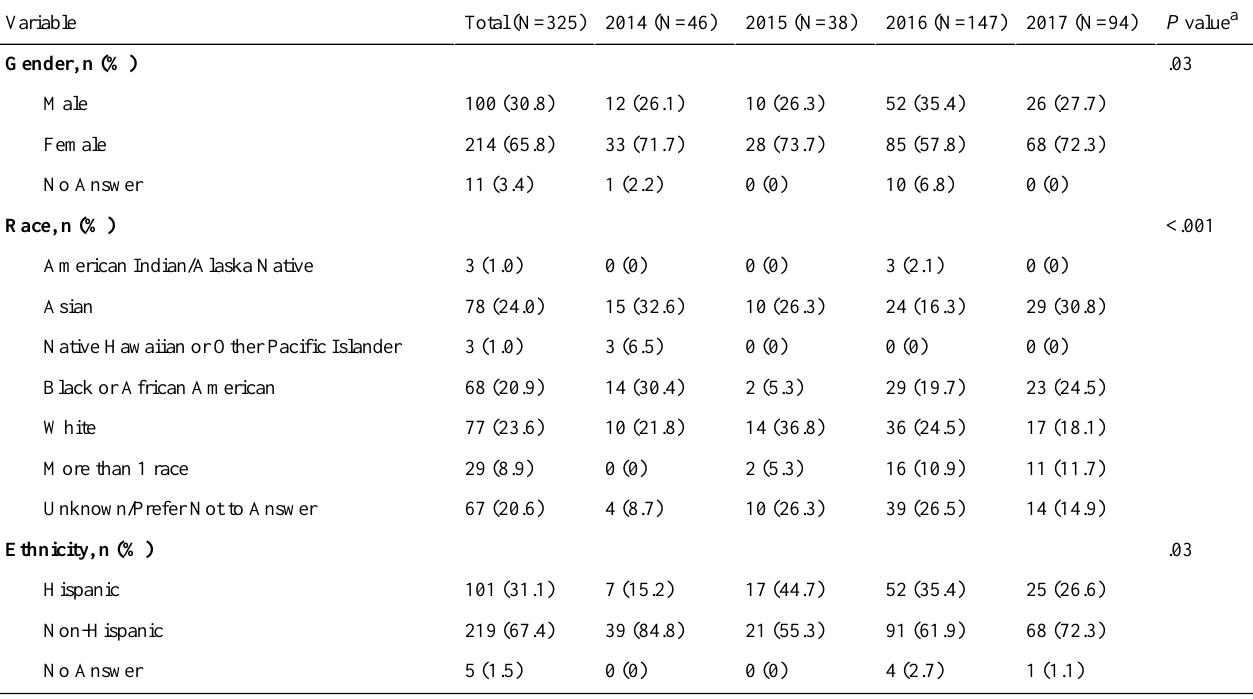
Table 1. Demographic information of recruited friends by year.